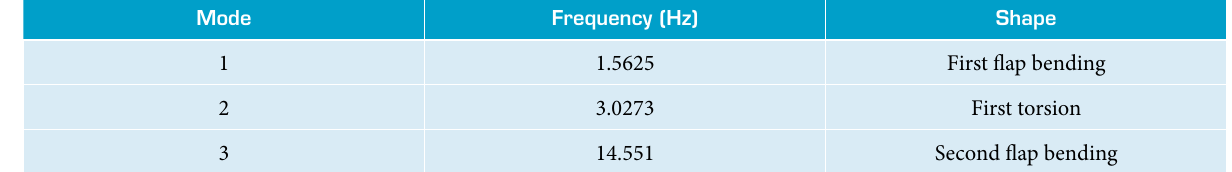
Figure 6. Frequency response functions measured. Table 2. Vibration modes experimentally obtained.